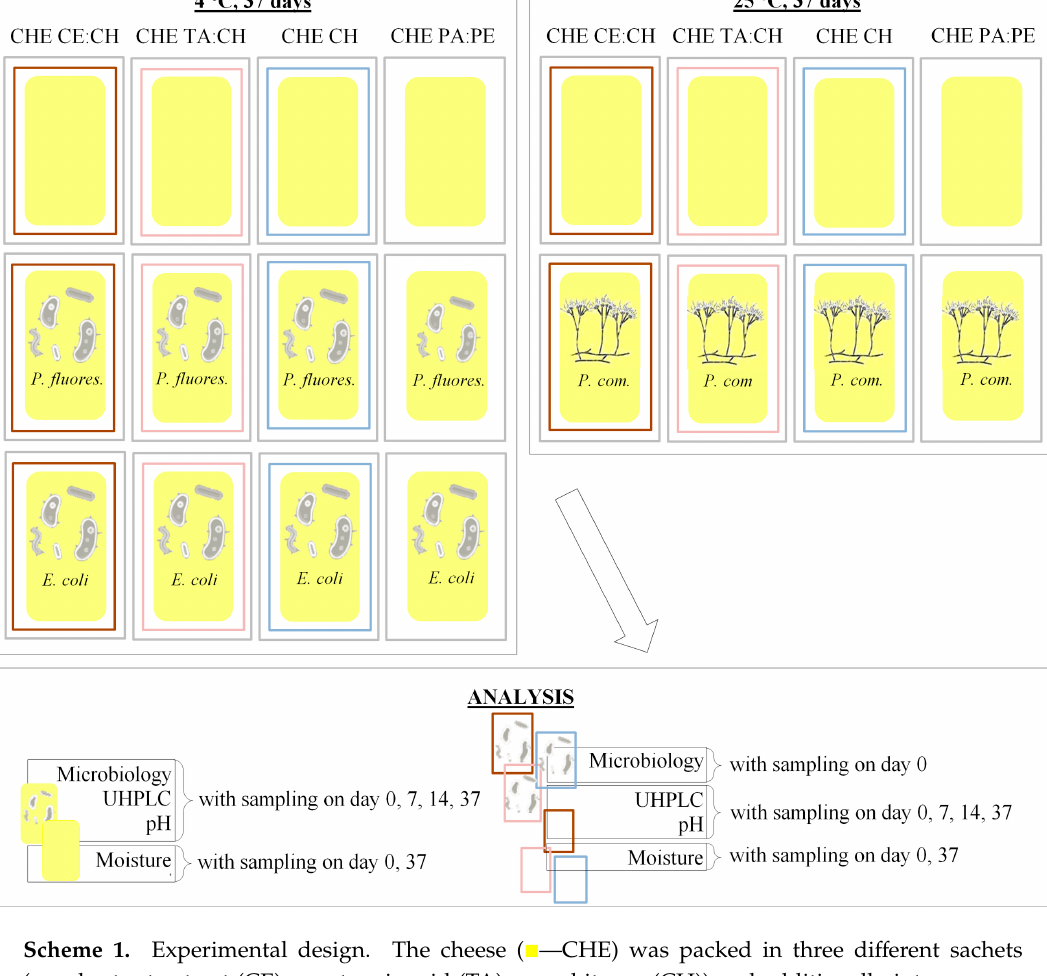
Table 1. Abbreviations used in the